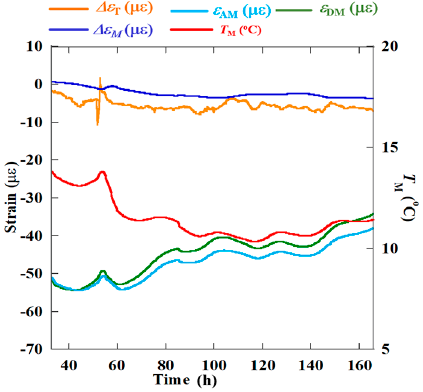
Figure 13. Signal pattern of the voltage before corrosion is applied with the moving average.